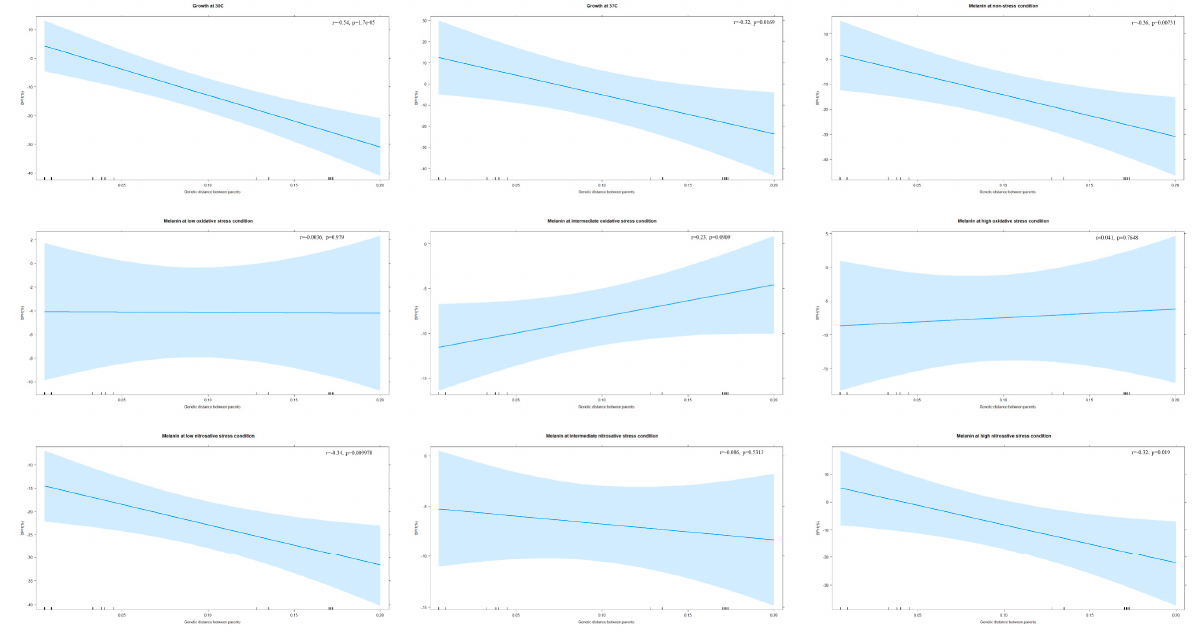
Figure 3. Effects of parental genetic divergence on %BPH (better-parent heterosis) in growth (30 ◦ C and 37 ◦ C) and melanin synthesis (non-stress, low oxidative stress, intermediate oxidative stress, high oxidative stress, low nitrosative stress, intermediate nitrosative stress, and high nitrosative stress). The x -axis shows the genetic distance between parental pairs. The y -axis represents the percentage of